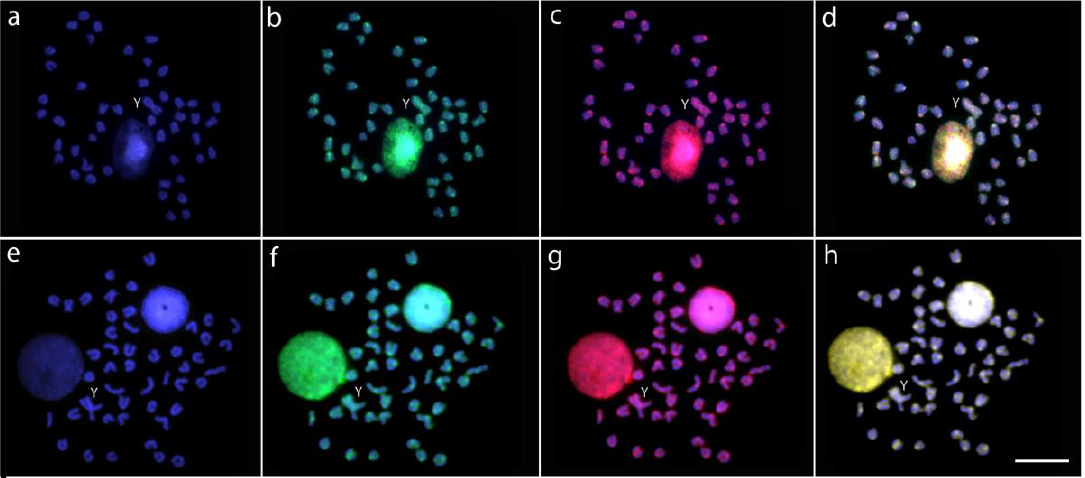
Figure 4. Mitotic chromosome spreads of males of O . fasciatus ( a – d ) and O . punctatus ( e – h ) after male vs. female comparative genomic hybridization (CGH) experiments. The first column ( a and e ): DAPI images (blue); second column ( b and f ): Hybridization pattern of the female-derived probe (green) of each analyzed species; third column ( c and g ): Hybridization pattern of the male-derived probe (red) of the respective species. The fourth column ( d and h ): Merged images of both genomic probes and DAPI staining. The common genomic regions for male and female are depicted in yellow. The Y chromosome is indicated. Scale bar = 10 µm